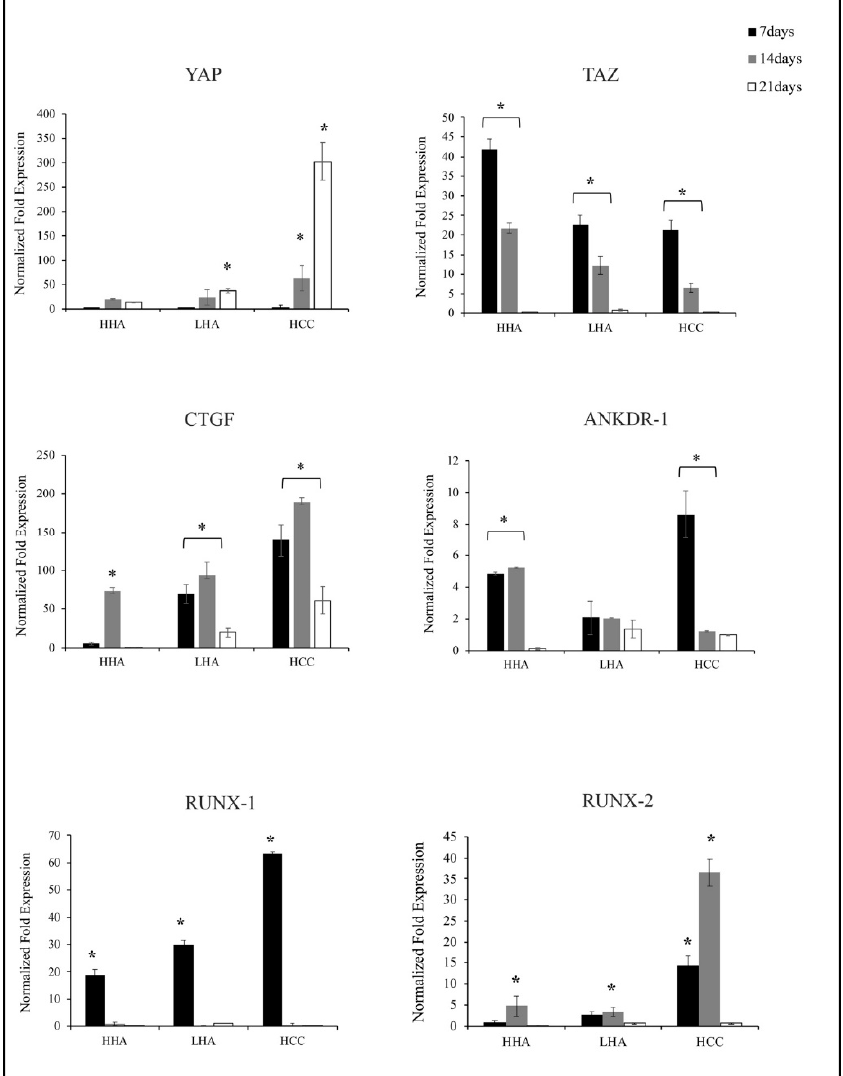
Figure 4. Analysis of YAP , TAZ , CTGF , ANKDR-1 , RUNX-1 and RUNX-2 gene expression at 7, 14 and 21 days by qRT-PCR in standard medium. YAP is slightly upregulated from 14 to 21 days by HHA, LHA, and strongly activated by HCC; TAZ expression increased earlier, at 7 and 14 days, in particular with HHA; CTGF mRNA levels were upregulated by all HA-based gels up to 14 days, with a better upregulation exerted by HCC; ANKDR-1 gene expression was strongly upregulated by HCC already at 7 days; RUNX-1 gene expression was increased by all hyaluronans at 7 days, with a better effect of HCC; RUNX-2 increased with HCC up to 14 days. The results are expressed as the mean ±SD of three independent experiments. * p < 0.01 vs. CTR.